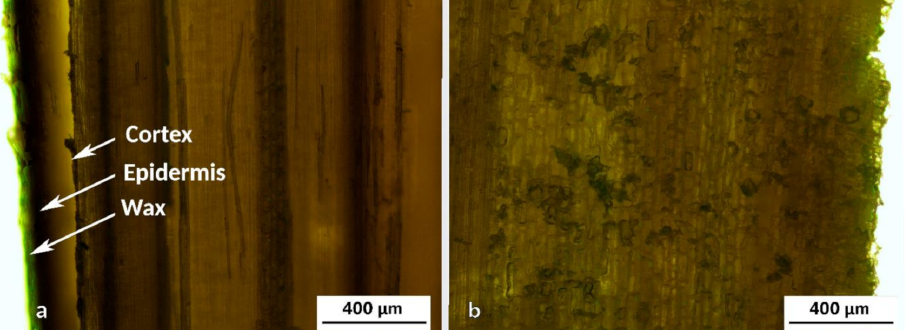
Figure 7. OM micrographs from longitudinal cuts of AA bamboo: ( a ) outer part and ( b ) inner